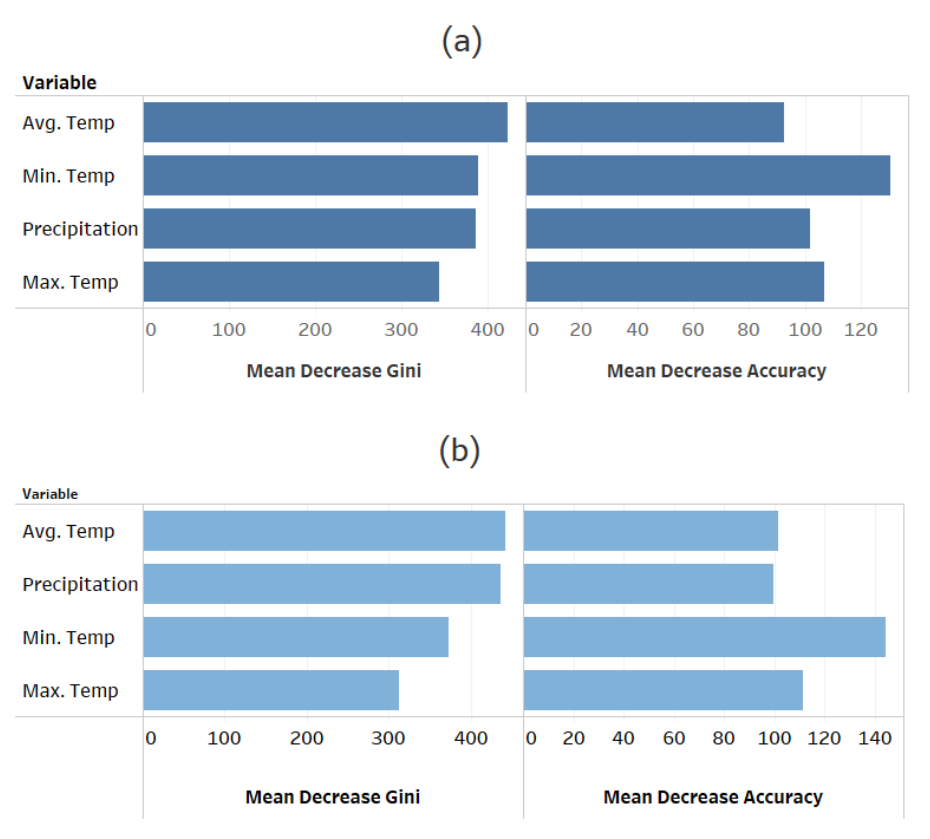
Figure 6. Mean decrease Gini and mean decrease accuracy in ( a ) Random Forest model with 300 trees and ( b ) Random Forest model with 1000 trees.